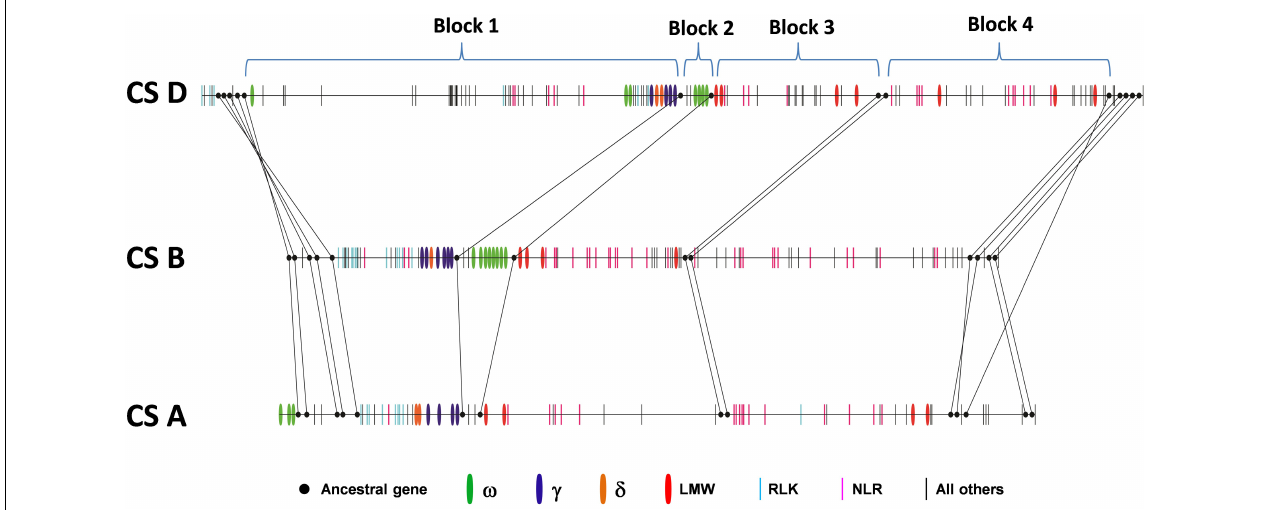
FIGURE 2 | Collinearity of orthologous regions harboring prolamin and resistance gene families from the wheat A, B, and D genomes. Ancestral genes that are shared with grass genomes are shown in solid dots and connected with lines. Other genes are represented by vertical bars with colors to indicate different types of prolamins and resistance genes. Black bars represent genes other than prolamin or resistance